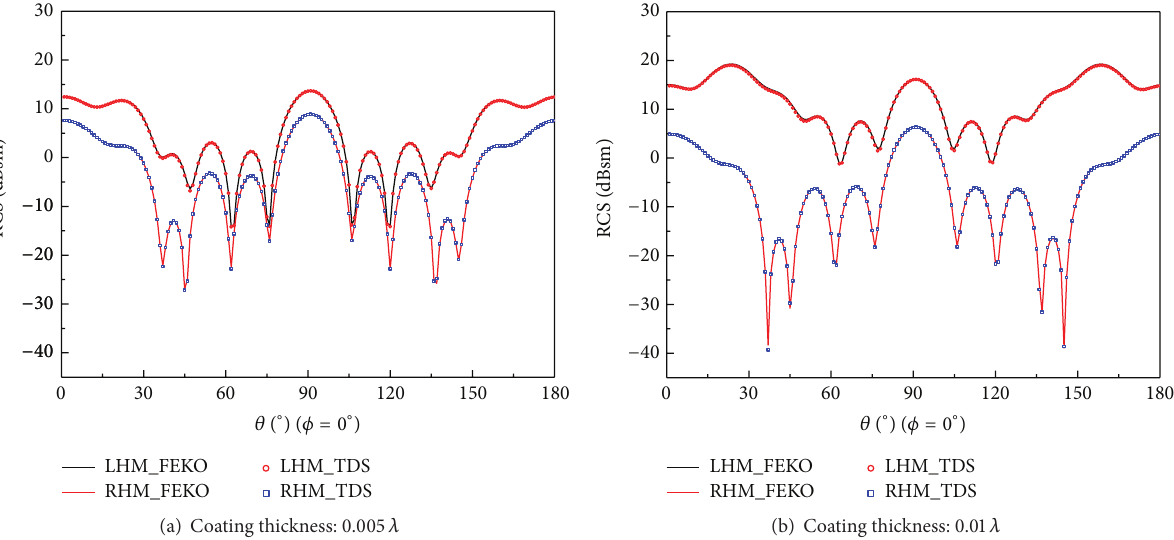
Figure 4: VV polarization monostatic RCS of coated cylinder.